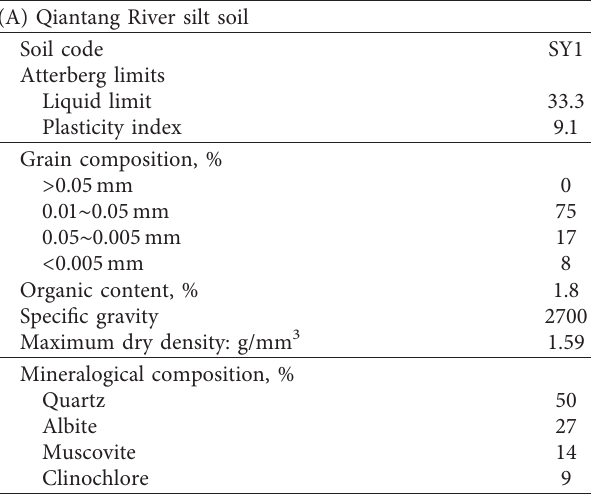
Figure 3: Display steps of the Tianluoshan site. (a) Display steps in the west of the site. (b) 2nd layer of soil collapse in the west of the site. Table 1: Grain-size composition, Atterberg limits, organic content, specific gravity, and mineralogical composition of the tested sediments (SY1 and SY2) evaluated by X-ray